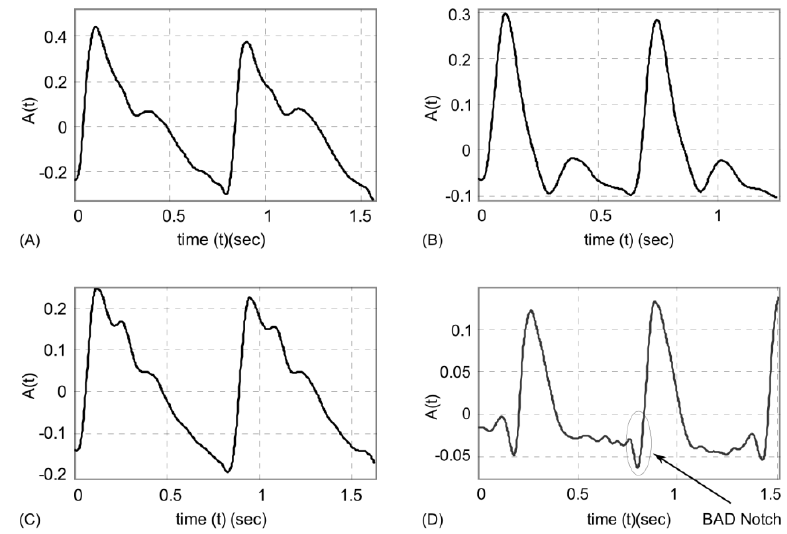
Figure 3. ( A – C ) pulse patterns of young healthy persons: (A) taut, (B) slippery, (C) moderate. Plot ( D ) illustrates abnormal pulse pattern containing BAD